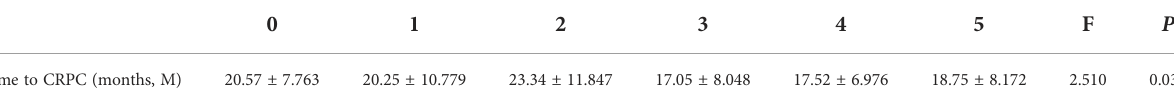
TABLE 5 Time of MetS score subgroup progression to CRPC (month, M).